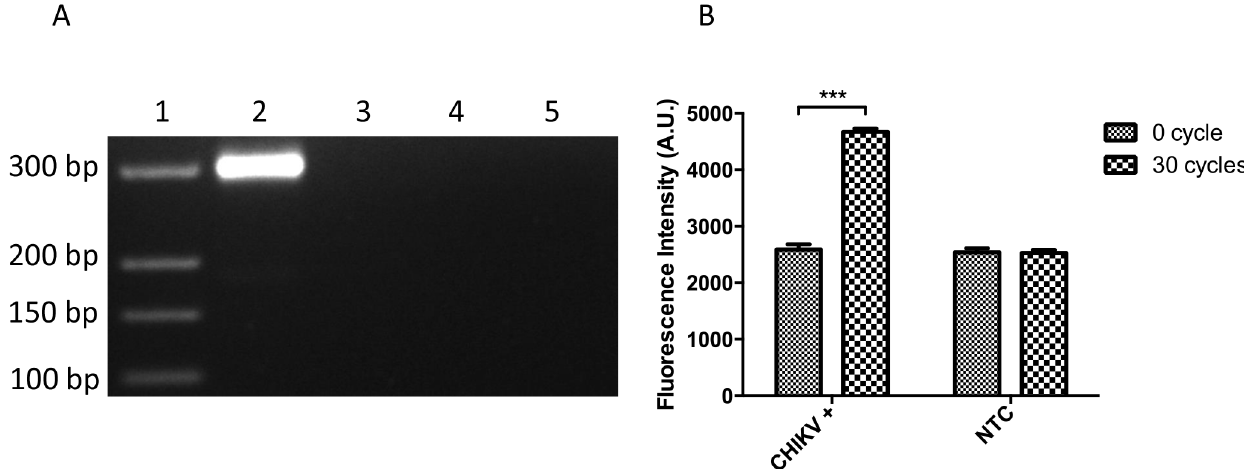
Fig 3. DANP-anchored RT-PCR primer was evaluate. A: Specific PCR product with expected size (296 bp) is observed only in reaction with CHIKV RNA template after 30 PCR cycles. Lane 1, DNA ladder (GeneRuler Ultra Low Range, Thermal Fisher Scientific, Waltham, Massachusetts, USA); lane 2, CHIKV RNA+ after 30 PCR cycles; lane 3, CHIKV RNA+ before PCR; lane 4, NTC after 30 PCR cycles; and lane 5, NTC before PCR. B: The fluorescence intensity from the PCR reactions with and without CHIKV RNA before and after 30 PCR cycles. Only the reaction with CHIKV RNA shows significant increment in fluorescence intensity (approximately 2000 AU) after 30 cycles of PCR reaction. Data are shown as means SEM of five experiments. *** P < 0.001 by Student ’ s t-test.